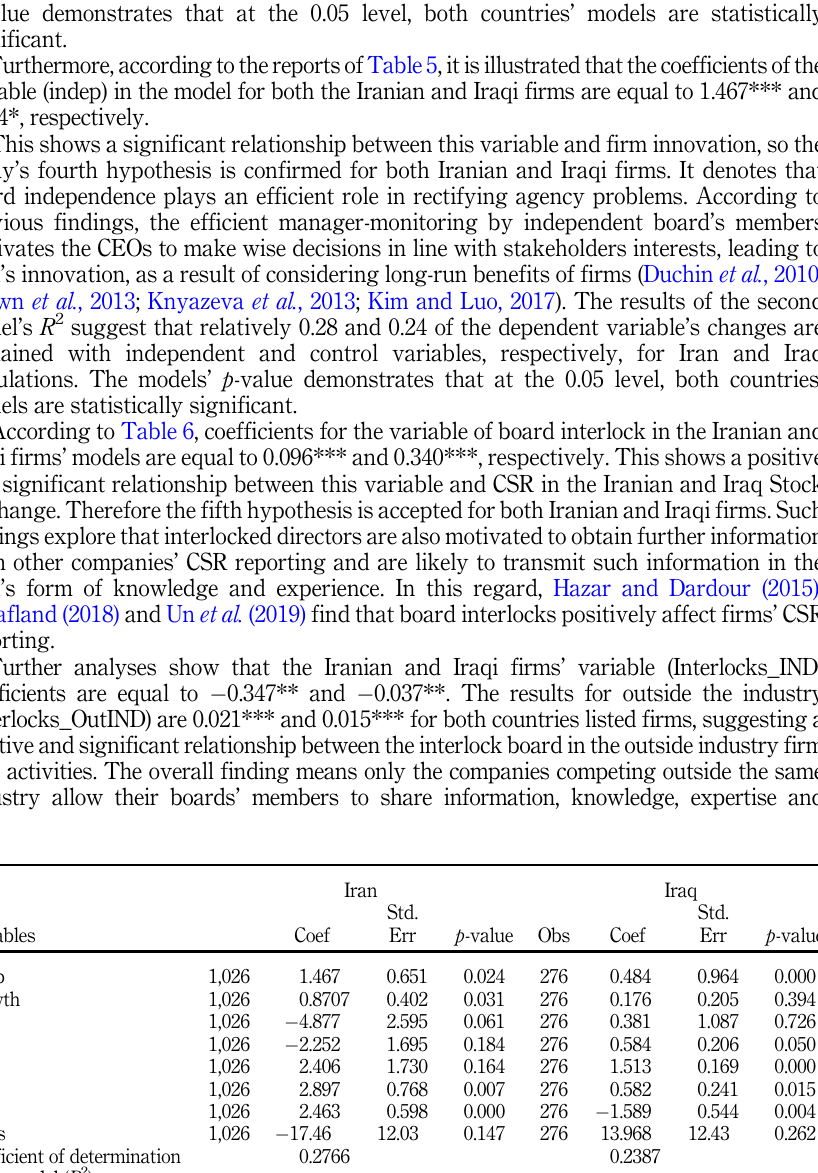
Table 5. The results of